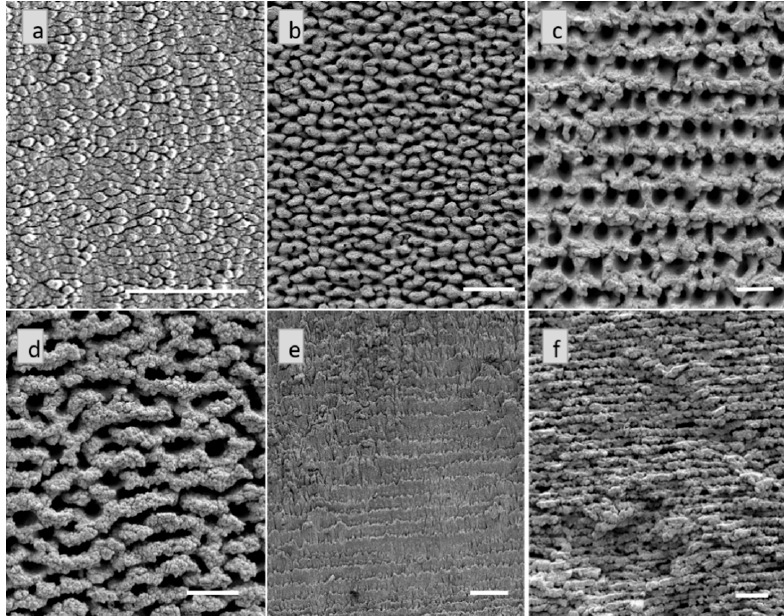
Figure 2. Representative images of the microstructures on Ti machined at 1 kHz. ( a ) Undulating grooves; ( b ) Bumpy structures; ( c ) Holes; ( d ) Chaotic structures; ( e ) Stalagmites and ( f ) Aggregate structures. All scale bars represent 50 µm. Table 2. Microstructures fabricated at the two repetition rates. Microstructures